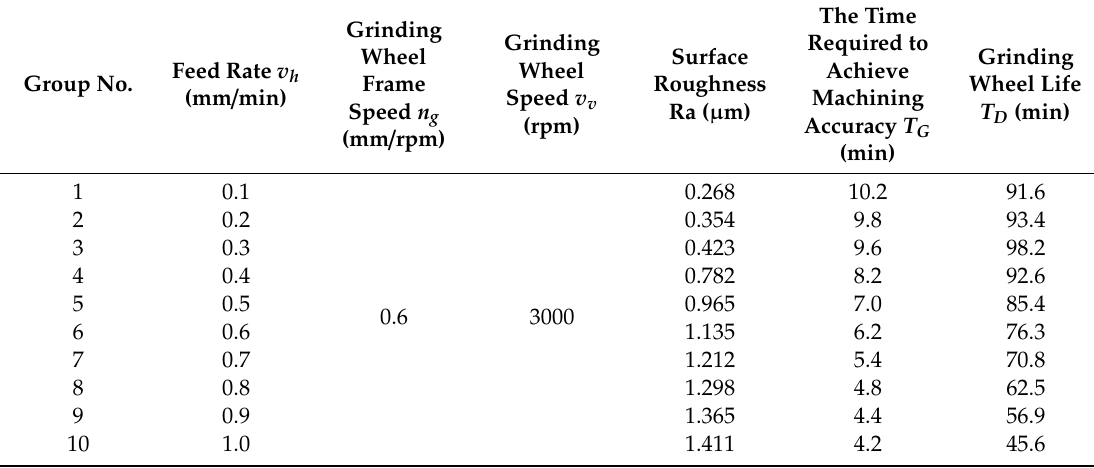
Table 7. The experiment grouping and results of exploring the impact of the feed rate.